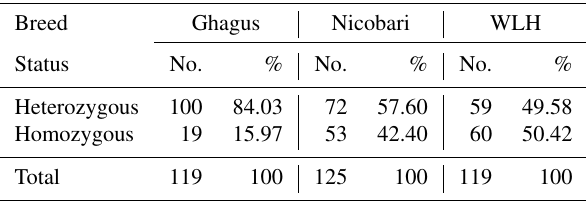
Table 4. Genetic identity/distance among three breeds of chicken. Population/breed Ghagus Nicobari WLH Ghagus – 0.106 0.293 Nicobari 2.244 – 0.411 WLH 1.227